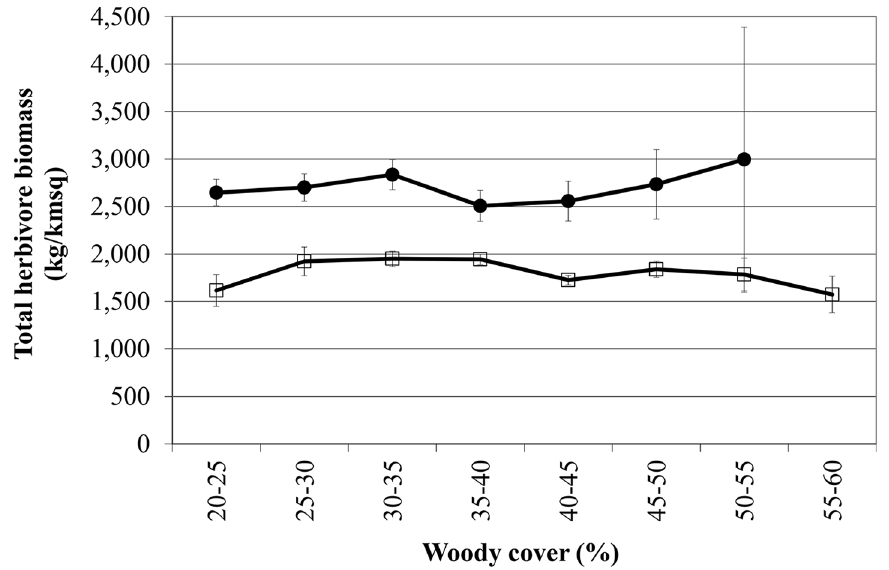
Fig 3. Average Total Herbivore Biomass (THB) (kg.km -2 ) observed for 12 large herbivore species along a woody cover gradient. (basalts: solid circles; granites: open squares) (standard error bars included). As expected the nutrient-rich basalts support higher biomass than the nutrient-poor granites. Surprisingly, even though nine of the 12 individual species studied show significant directional increases or decreases along the woody cover gradient (see Fig 2 and Table 2), when all species are combined the average THB stays constant between 20 – 65% woody cover with no change in productivity (refer to Table 3 for slope coefficients).